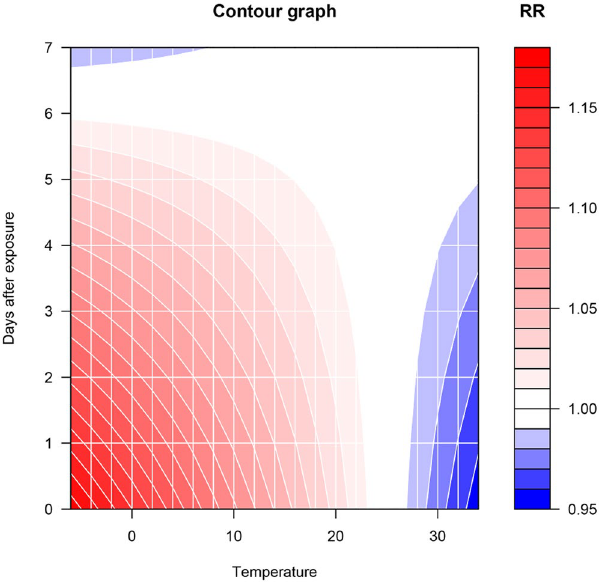
Figure 3. The adjusted effect of temperature on ICUp. As expectedly, low temperature was associated with increased risk of ICUp. In contrast to the effect of PM2.5, temperature appeared to have immediate effect after